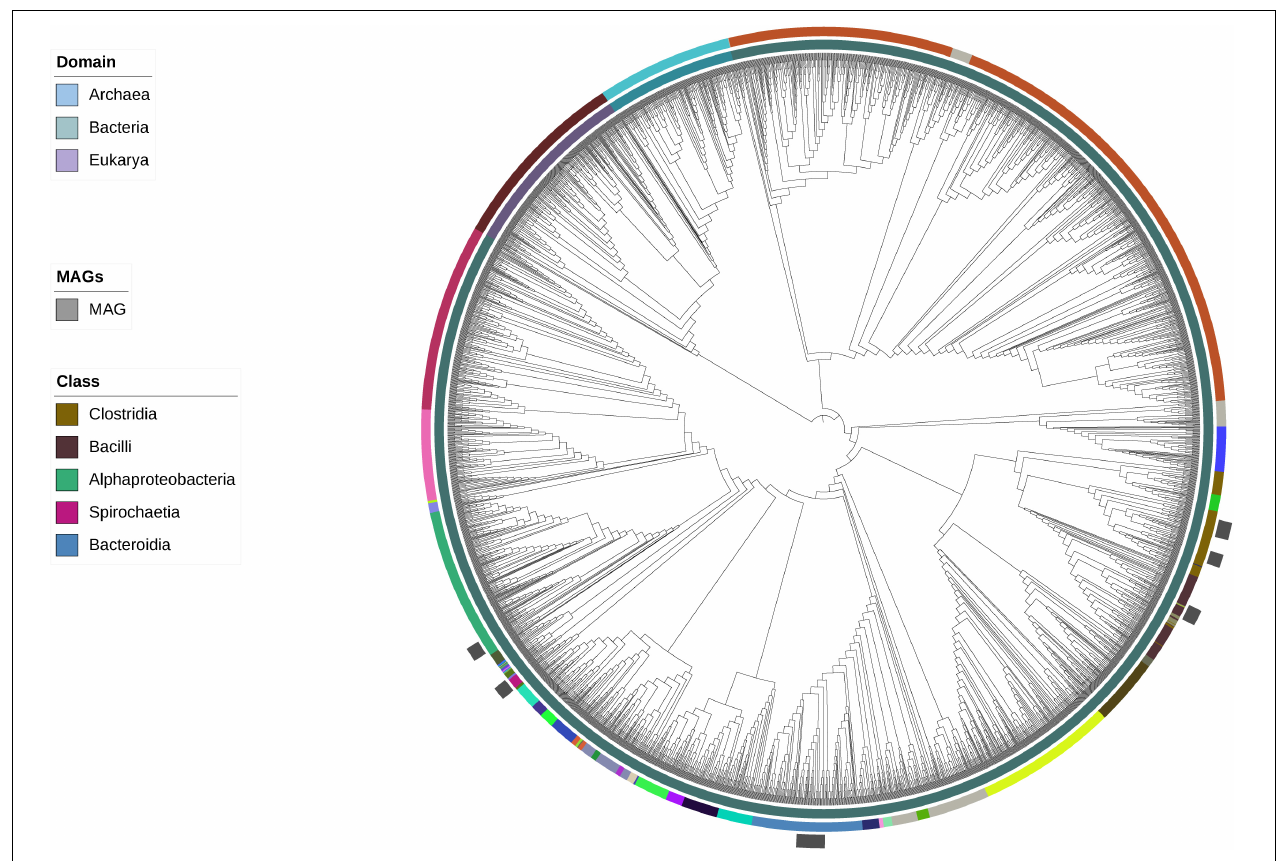
FIGURE 2 | Bootstrapped maximum-likelihood tree based on concatenated ribosomal marker genes including representative MAGs found in this study placed onto the phylogenetic tree proposed by Hug et al. (2016). Clades are colored based on both domain and order, but only orders that are relevant to the MAGs are presented in this study, as shown by gray